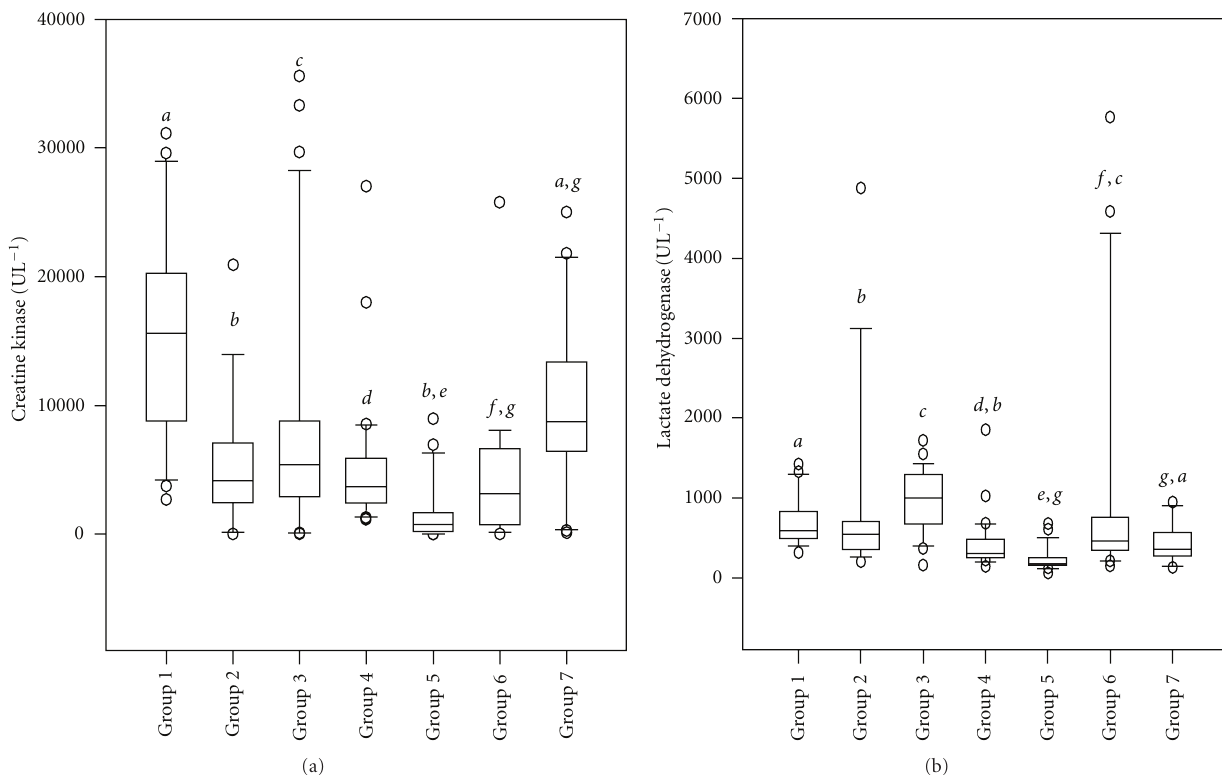
Figure 2: The box plots of (a) creatine kinase (CK) and (b) lactate dehydrogenase (LDH) enzymes activity values in the serum/plasma of Atlantic salmon for all seven groups ( N = 173). Group 1 ( n = 28) and group 2 ( n = 16) represented fish from an acute and late phase of a HSMI outbreak, respectively, while group 3 ( n = 31) represented values from fish from an early phase of HSMI. Group 4 ( n = 30) included chronic CMS fish. Group 5 ( n = 28), group 6 ( n = 20), and group 7 ( n = 20) represented values from nondiseased fish. Bars with di ff erent letters represented significant di ff erences between groups ( P < 0 . 05). ( ◦ ) denotes